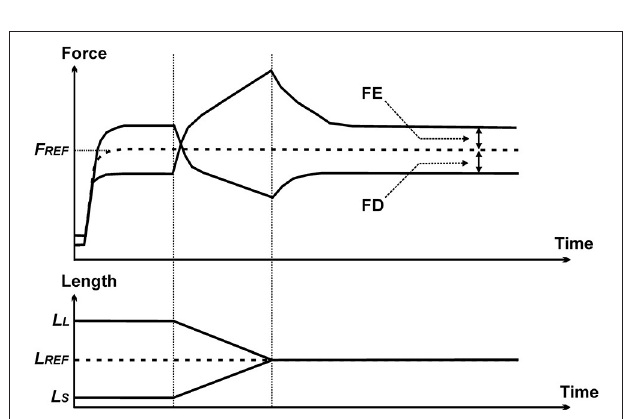
FIGURE 11 | Normalized force–velocity relationship of a skeletal muscle showing the well-known hyperbolic relationship between the maximal, steady-state force of a muscle as a function of its speed of shortening.